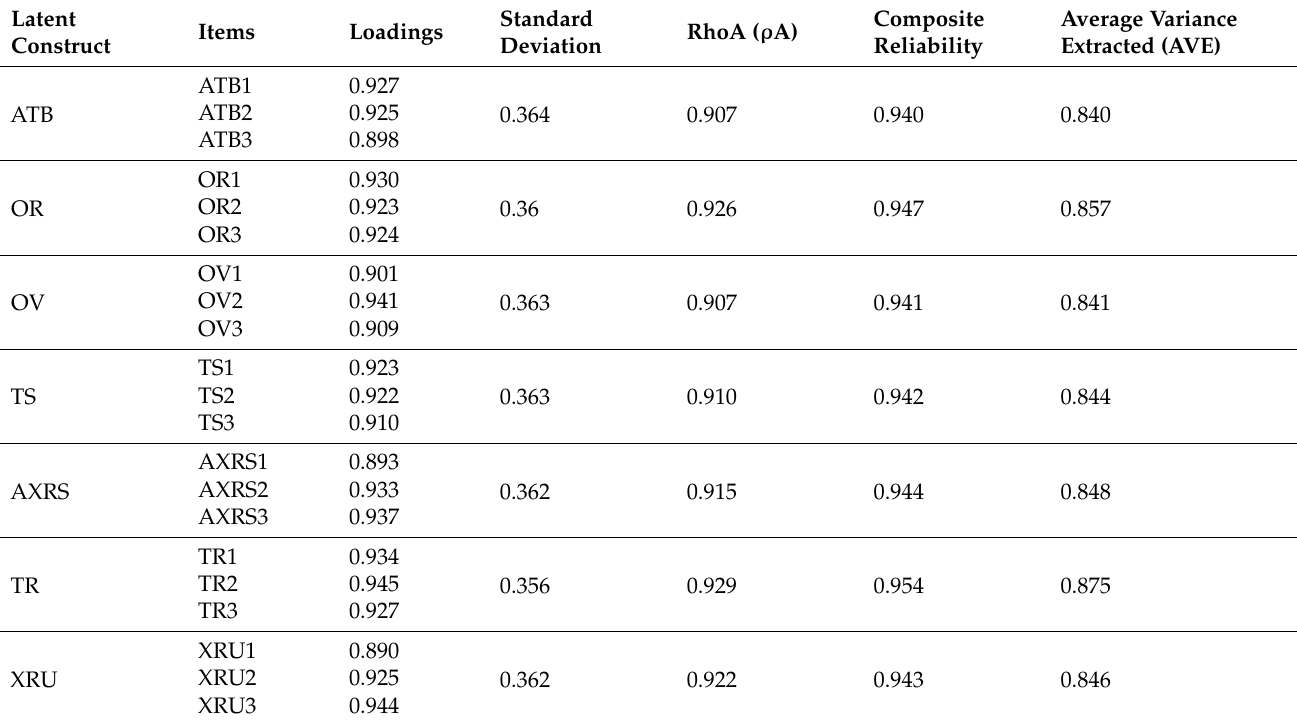
Table 3. Convergent validity and construct reliability.